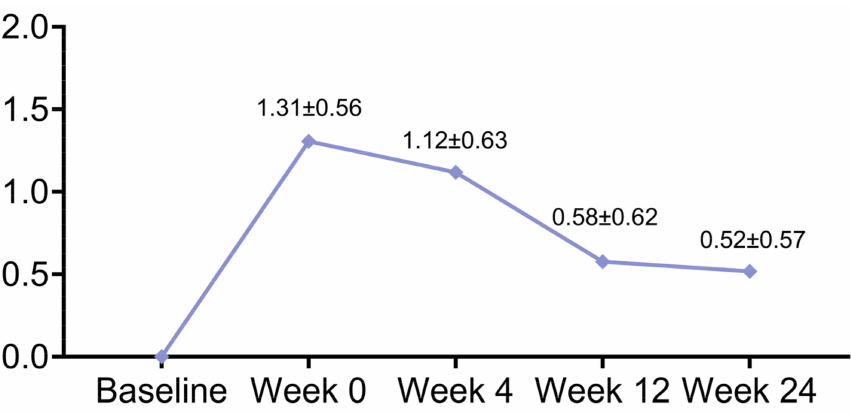
Figure 3. The mean improvement in WSRS scores from baseline at each follow-up visit. Values are the mean ± SD unless otherwise noted. Abbreviations: WSRS = Wrinkle Severity Rating